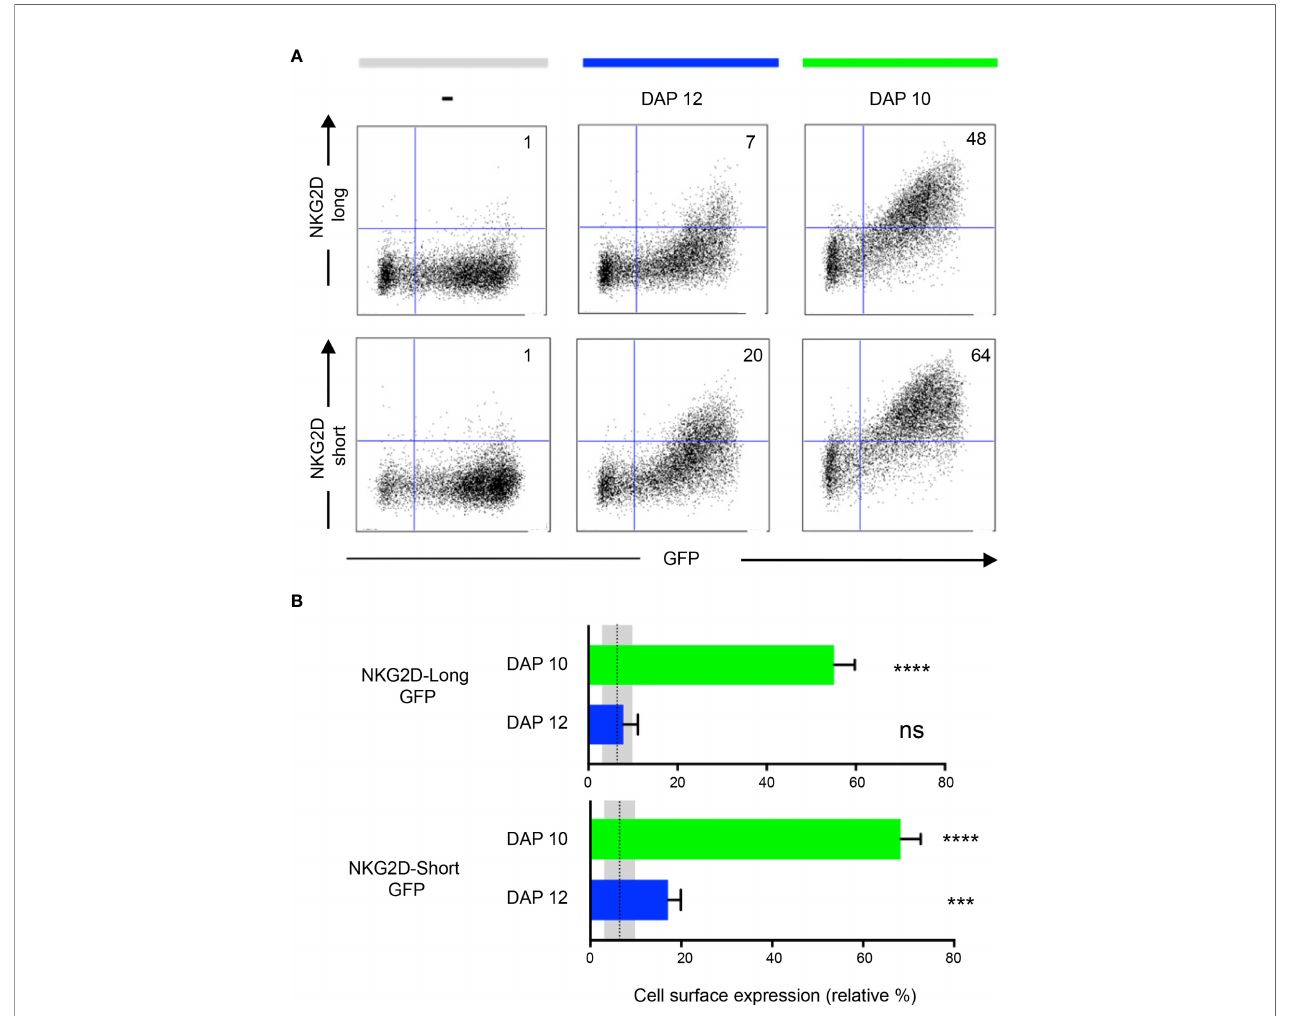
FIGURE 3 | NKG2D-GFP associates with adaptor proteins DAP10 and DAP12. (A) Expression of NKG2D-GFP short and long isoforms at the cell surface depends on the association with DAP10 or DAP12. Each NKG2D forms a homodimer, and each assembles with a DAP10/12 homodimer. Both NKG2D and Ly49A are type II membrane proteins ( i . e ., N terminus intracellularly and C terminus extracellularly). HEK 293T cells were transiently co-transfected with pTagGFP-NKG2D short or long isoform and either DAP12 or DAP10 as indicated. The cells were analyzed by fl ow cytometry for NKG2D surface expression. The numbers indicate the percentage of cells in the respective quadrant. One representative experiment is shown. (B) NKG2D-GFP short isoform associates with both DAP10 and DAP12. Both isoforms can associate with DAP10, but DAP12 associates signi fi cantly better with the short than with the long NKG2D-GFP isoform. The bar graphs show the mean percentage ± SD from four replicates, and the bars with a statistically signi fi cant difference are shown as follows: *** p<0.001, **** p<0.0001. ns, no statistically signi fi cant difference (p>0.05). Unpaired T -tests were performed to assess statistical signi fi cance in comparison with the untransfected control. The mean is represented by a dotted line, and the gray areas represent the mean percentage ± SD of untransfected control (-). The data are representative of three separate